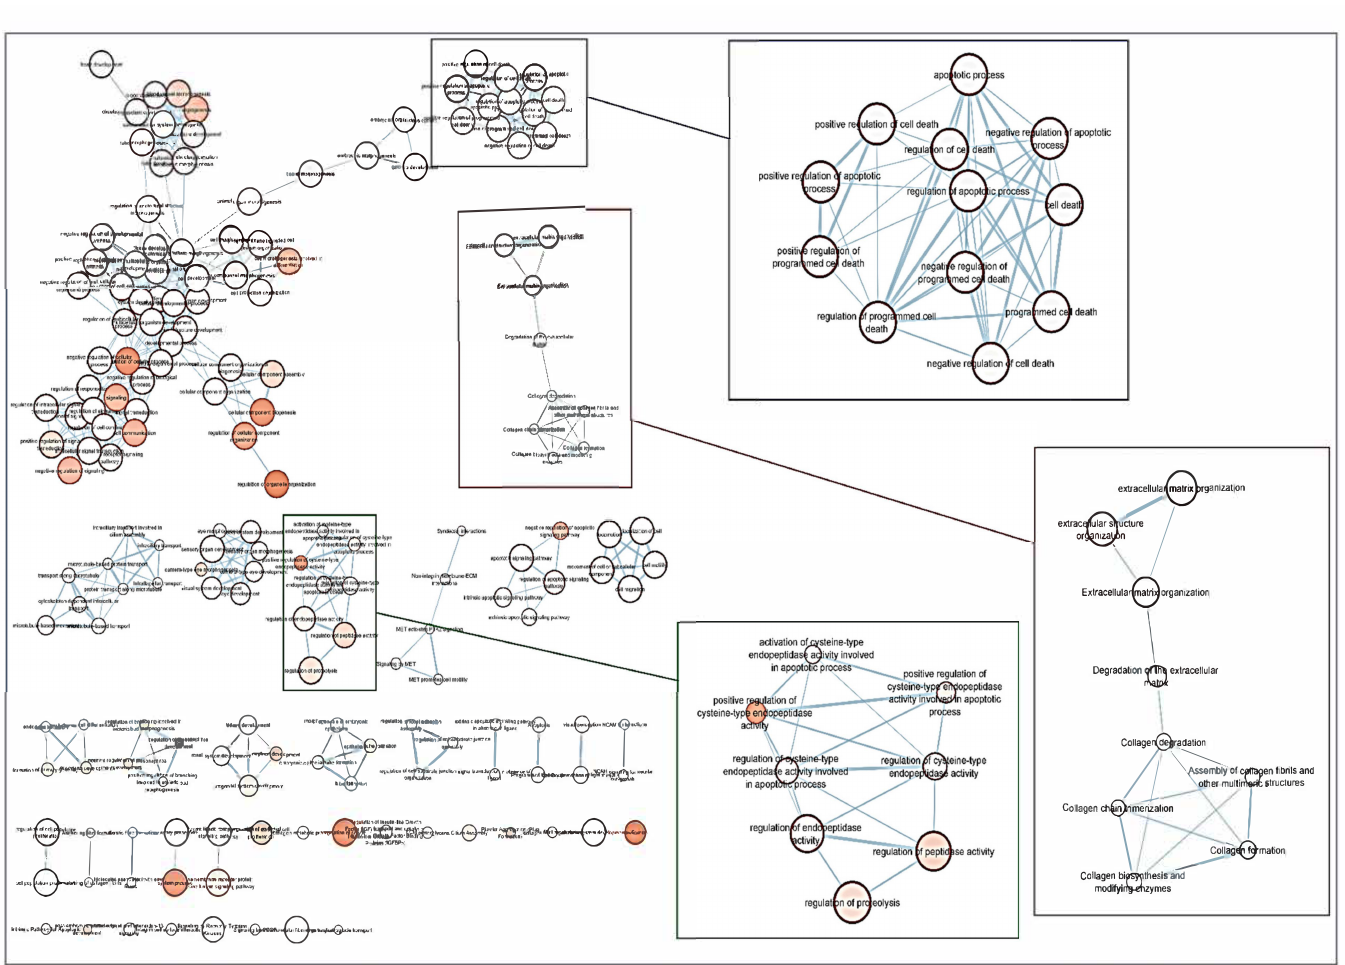
Figure 3. Network of GO terms and Reactome pathways generated with g:Profiler and EnrichmentMap in Cytoscape. Each node (circle) represents a gene set characterized by a particular GO term or reactome pathway. Node fill indicates the enrichment score (FDR q-value). The thickness of blue lines (edges) indicates the number of shared genes (overlap) between two connected nodes. Nodes with high overlap are clustered together, forming groups characterized by similar terms and pathways. Gene clusters involved in apoptosis (blue box), extracellular matrix and collagen concerns (red box), endopeptidase activity (green box) as well as in development pathways (upper left side) have been